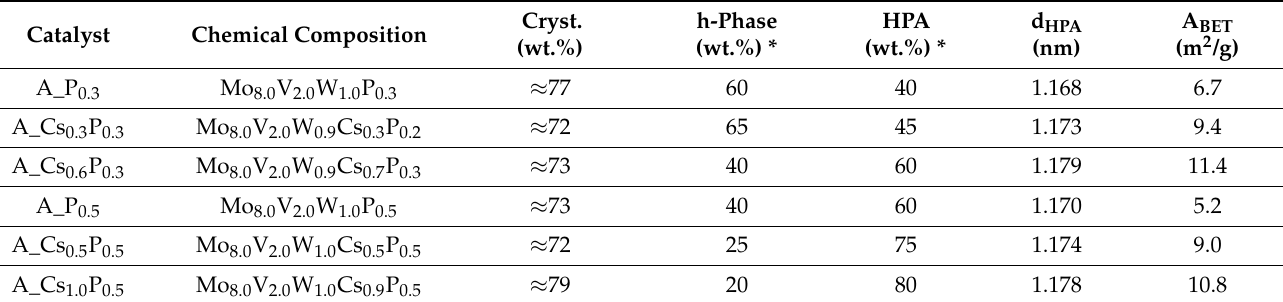
Cryst. h-Phase HPA d HPA A BET (wt.%) (wt.%) * (wt.%) * (nm) (m 2 /g)